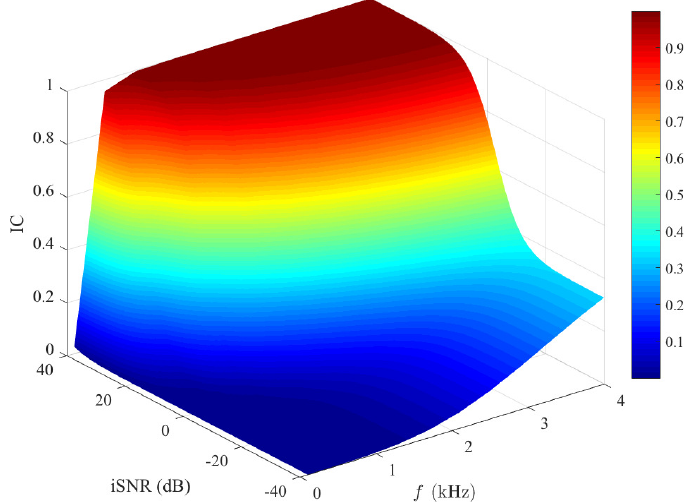
Figure 8. Output IC of the estimated signals (see (62)) as a function of frequency and input SNR. Conditions of simulation: M = 8, N = 4, α = 1, and δ = 1